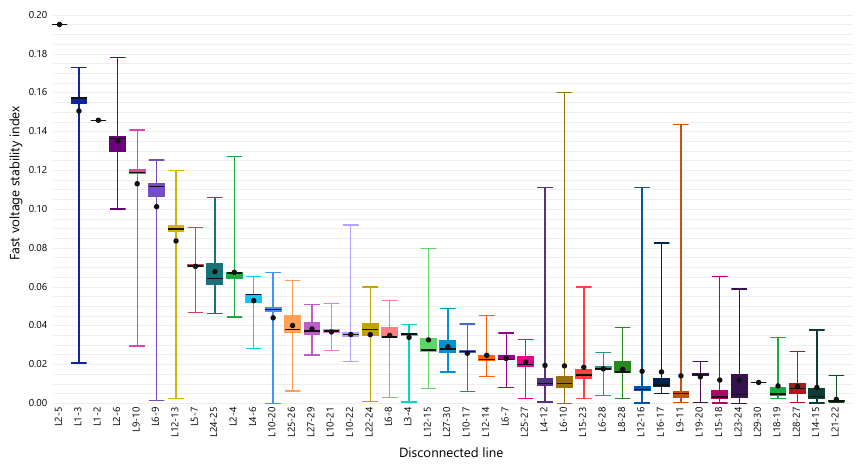
Figure 12. Thirty-bus-bar system: statistical analysis for every contingency scenario with optimal